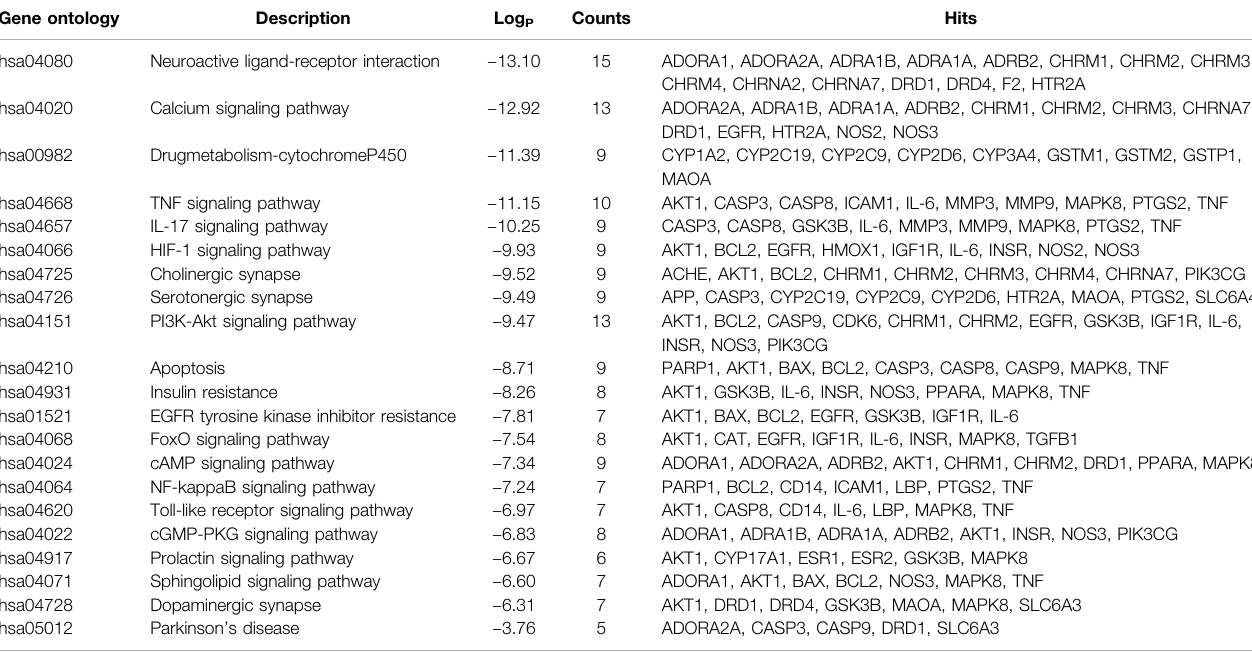
TABLE 2 | Kyoto Encyclopedia of Genes and Genomes pathway enrichment of Paeonia lacti fl ora P. for PD. Gene